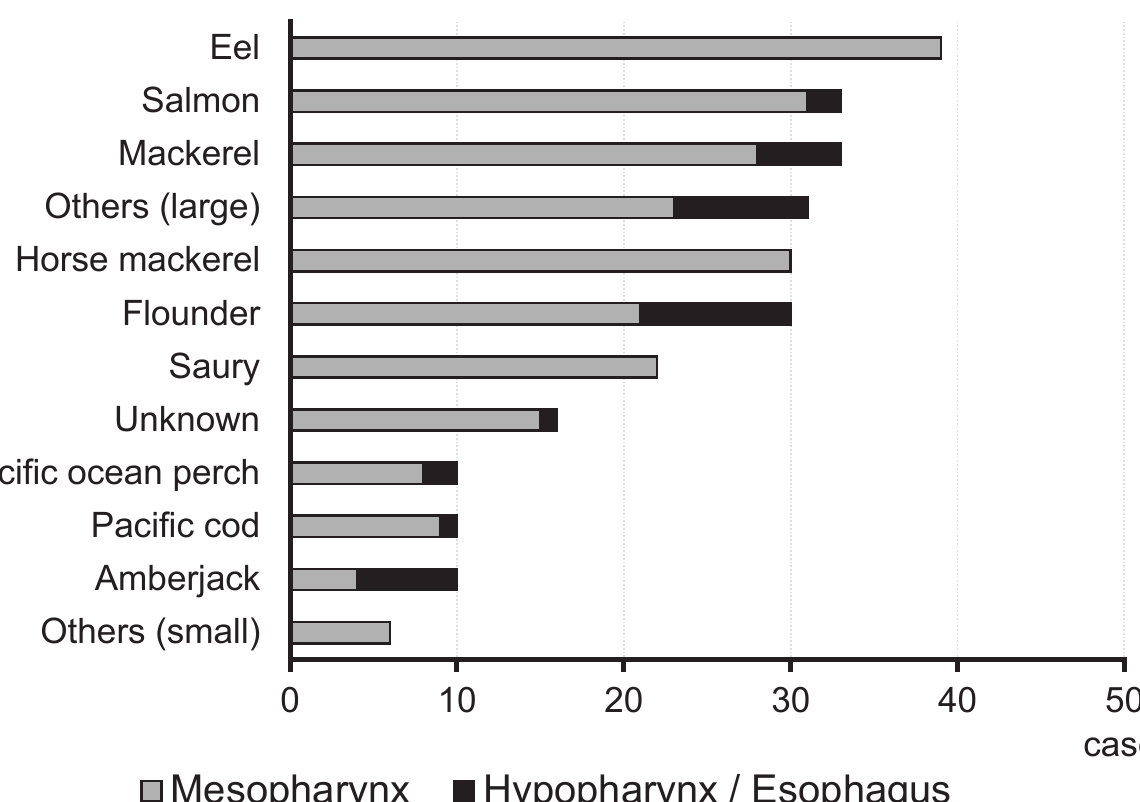
Fig 4. The locations (mesopharynx or hypopharynx/esophagus) of the fish bones for each fish type. The rate of hypopharynx/esophagus cases was significantly higher in the flounder group (flounder vs. the others, p = 0.0059).